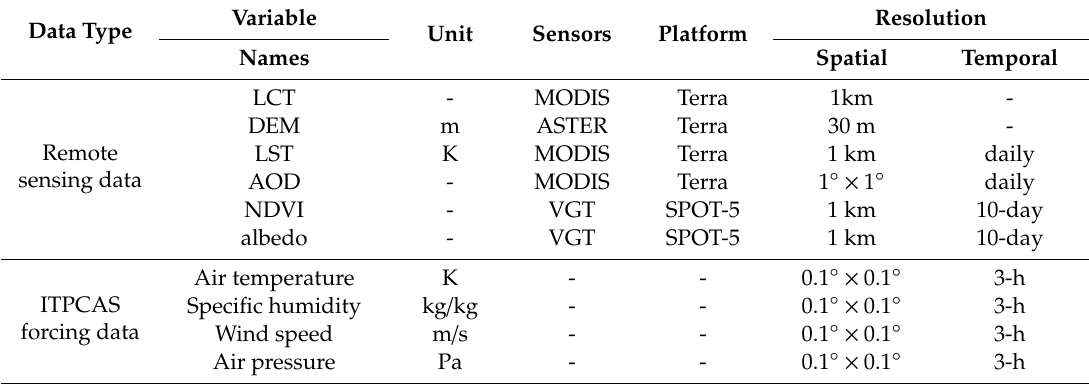
Table 1. Input datasets for calculation of actual evapotranspiration by the surface energy balance system